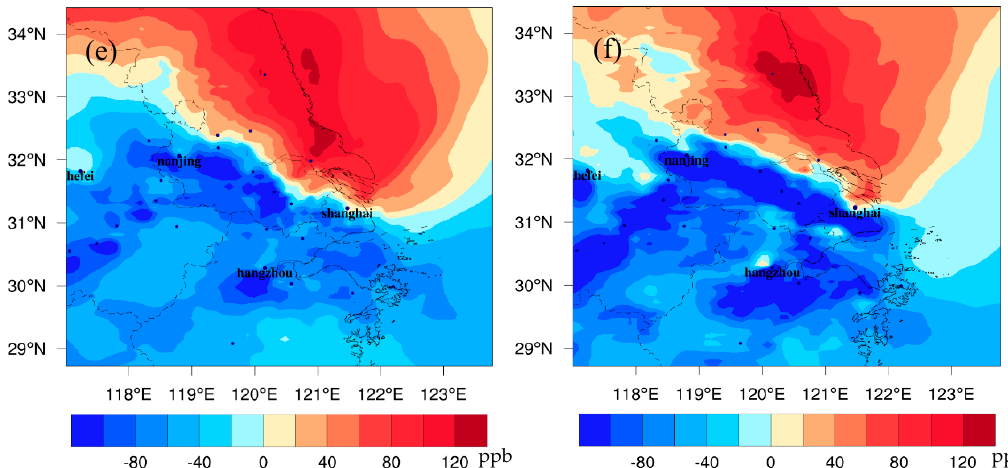
Figure 4. The spatial distribution of the monthly averaged differences of NO x ( a , b ), VOC ( c , d ), and CO ( e , f ) between FUTMET and PREMET. Figure 4a,c,e show the values during the daytime (from 7:00 to 18:00 LST). Figure 4b,d,f present those at night (from 19:00 to 6:00 LST).